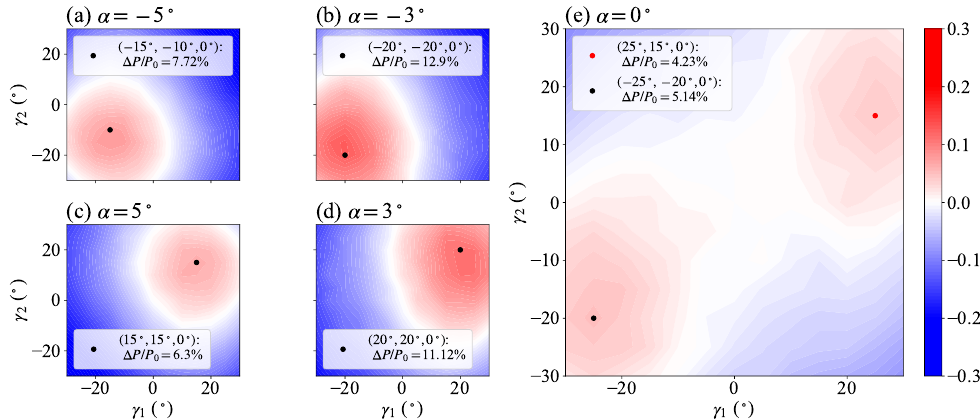
Figure 7. Normalised power gain contours in the AYC decision space Γ for different inflow angles. Black dots show the AYC configurations with the largest power